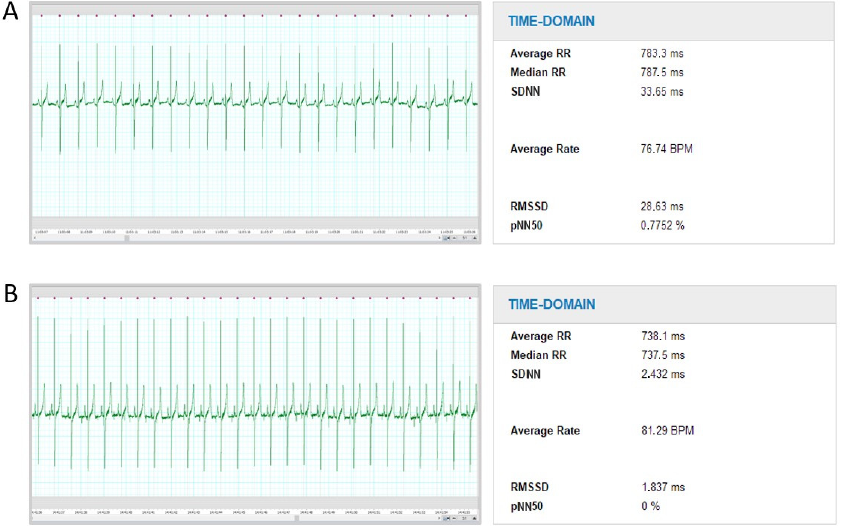
Figure 2. Representative example of HRV analysis comparing time-domain HRV parameters before ( A ) and after ( B ) acute CF induction in one study subject. BPM = beats per minute; pNN50 = number of pairs of adjacent NN intervals differing by more than 50 ms divided by the total number of all NN intervals; RMSSD = square root of the mean of the sum of the squares of differences between adjacent NN intervals; RR = interval between adjacent R waves; SDNN = standard deviation of intervals between normal beats. Variability Spectral frequency analysis of HRV also revealed significant changes following acute CF induction compared with the baseline. Significant increase in low frequency (LF) expressed in normalized units (n.u.; 5.3 [2.7–15.4] n.u. versus 9.5 [4.1–14.2] n.u., p = 0.01) and a low frequency over high-frequency ratio (LF/HF; 0.06 [0.03–0.09] versus 0.10 [0.04– 0.17], p = 0.008) was observed, whereas the high frequency (HF) significantly decreased (94.7 [91.7–97.3] n.u. versus 90.5 [85.8–95.9] n.u., p = 0.01; Figure 3).